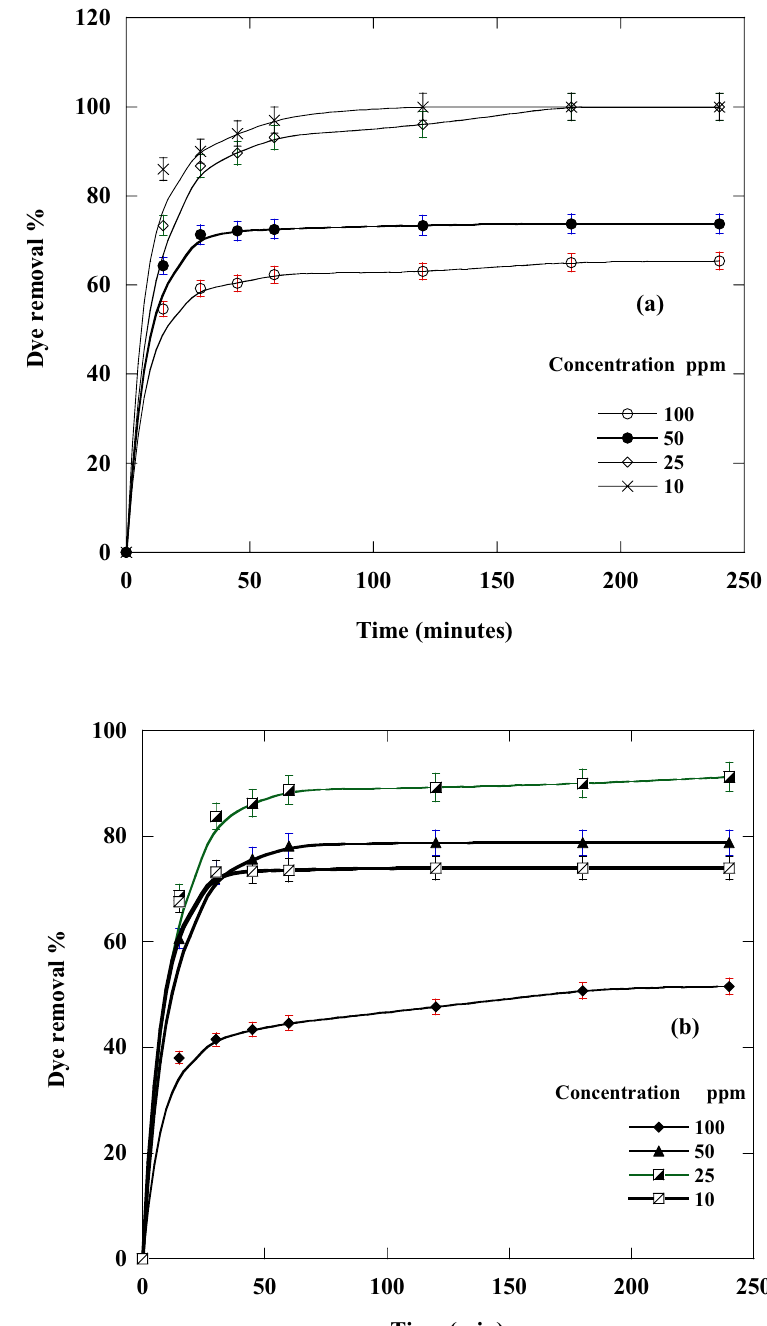
Figure 6. Effect of Disperse red 60 dye concentrations and contact time on the removal % of dye adsorbed at 20 °C and pH 6 by 50 mg of: ( a ) CF and ( b )